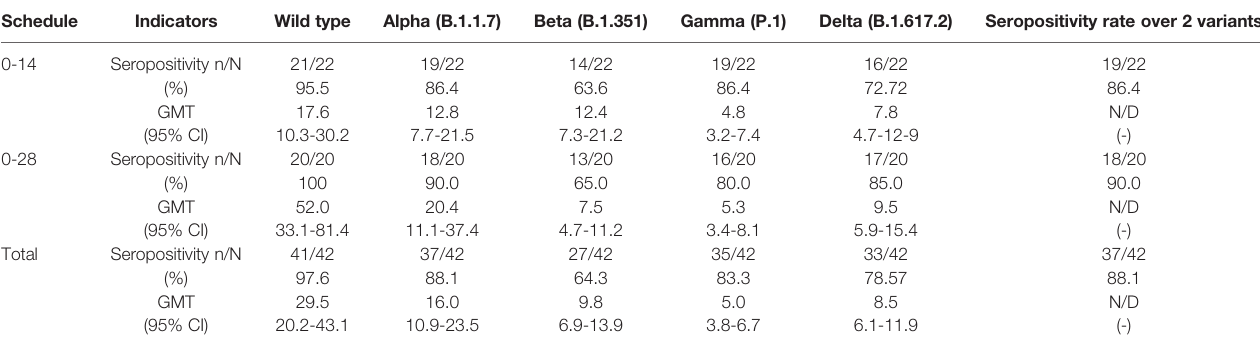
TABLE 1 | Seropositivity rates and geometric mean titer of antibodies that inhibit the RBDs of SARS-CoV2 variants, by sVNT.